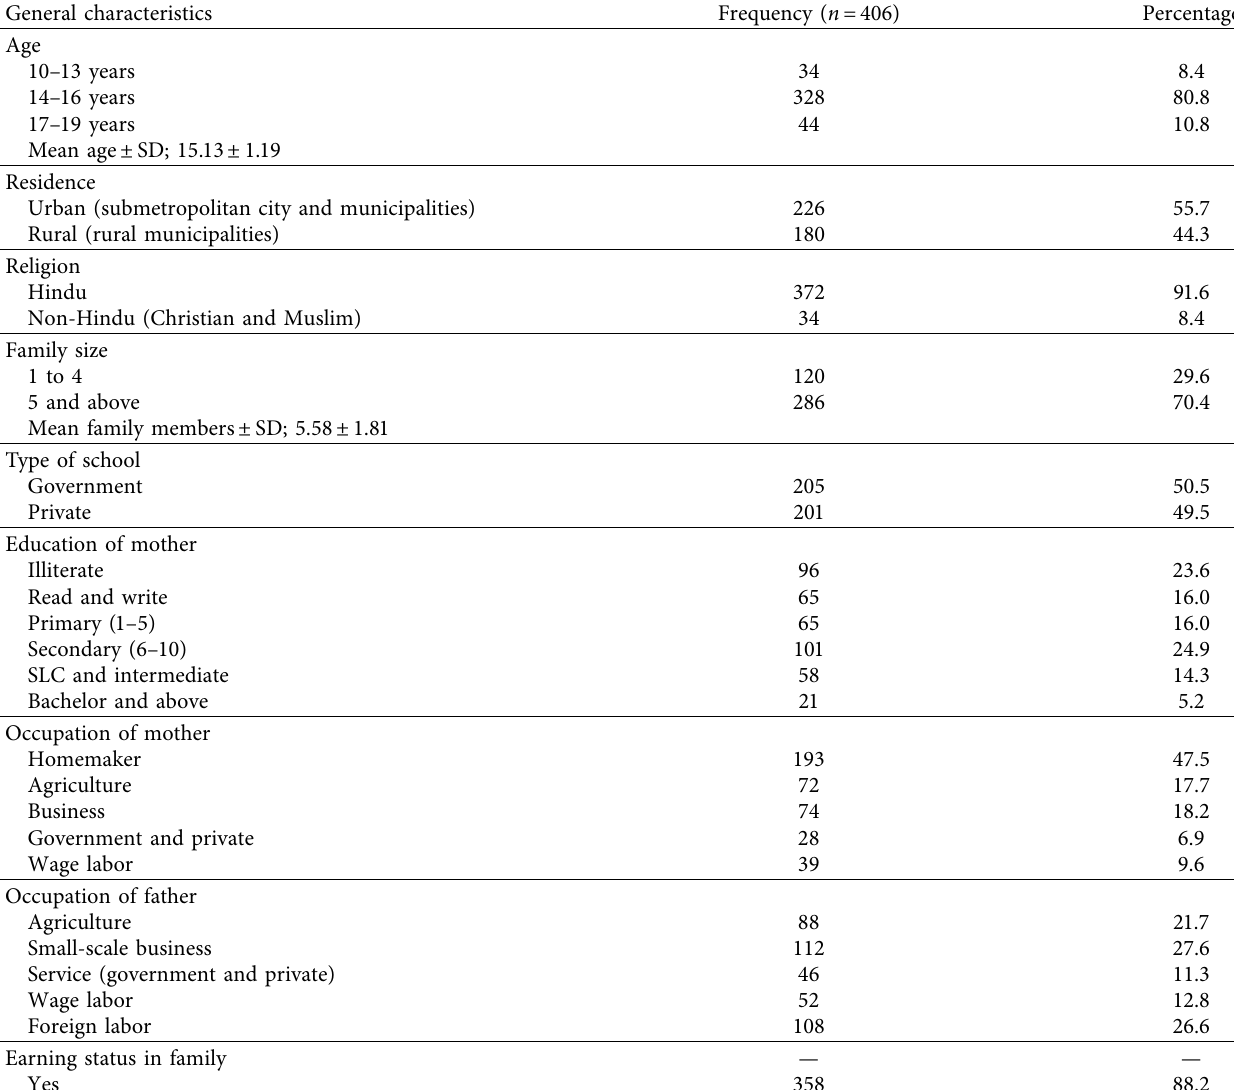
Table 1: Distribution of background related characteristics of study